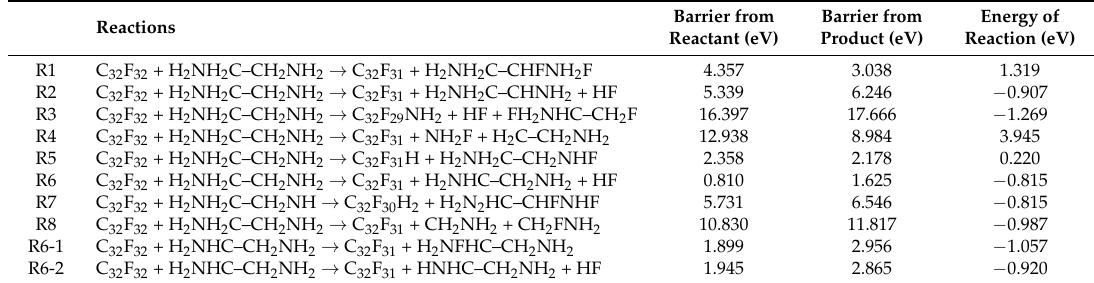
Barrier from Barrier from Energy of Reactant (eV) Product (eV) Reaction (eV)